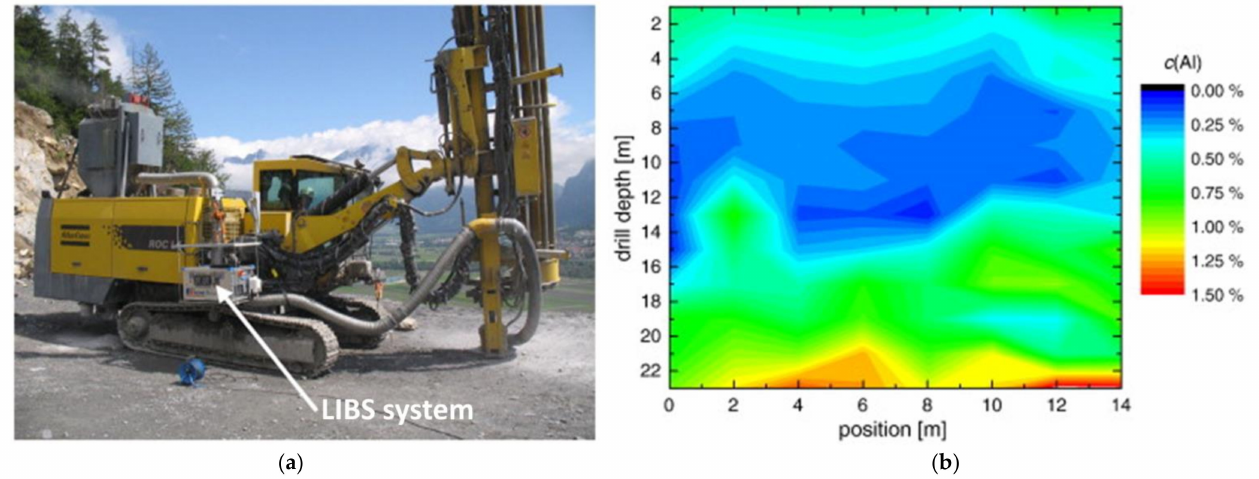
Figure 10. LIBS in-line measurement of drill dust in a quarry. ( a ) LIBS system mounted on a drill rig. ( b ) Measured spatial variation of Aluminum concentration as a function of drill depth and horizontal position of the mobile drill rig. Adapted from